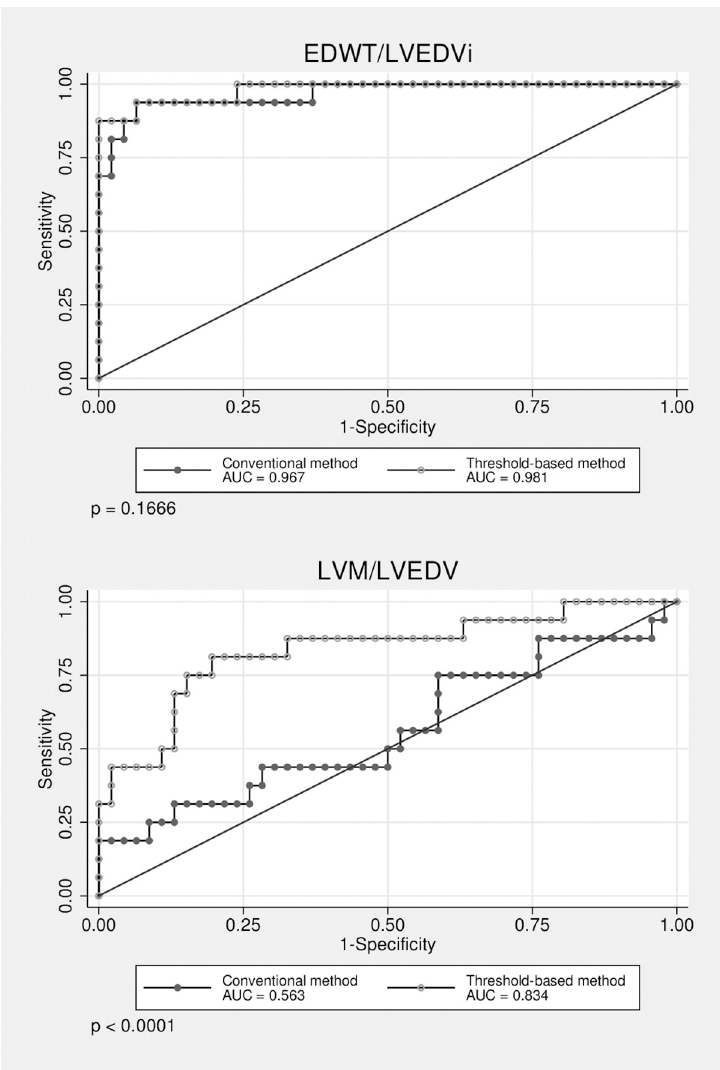
Fig 5. ROC curves visualizing correct identification of HCM among subgroup of individuals with EDWT between 13–16 mm, p values represent the difference in diagnostic performance between conventional and threshold- based quantification